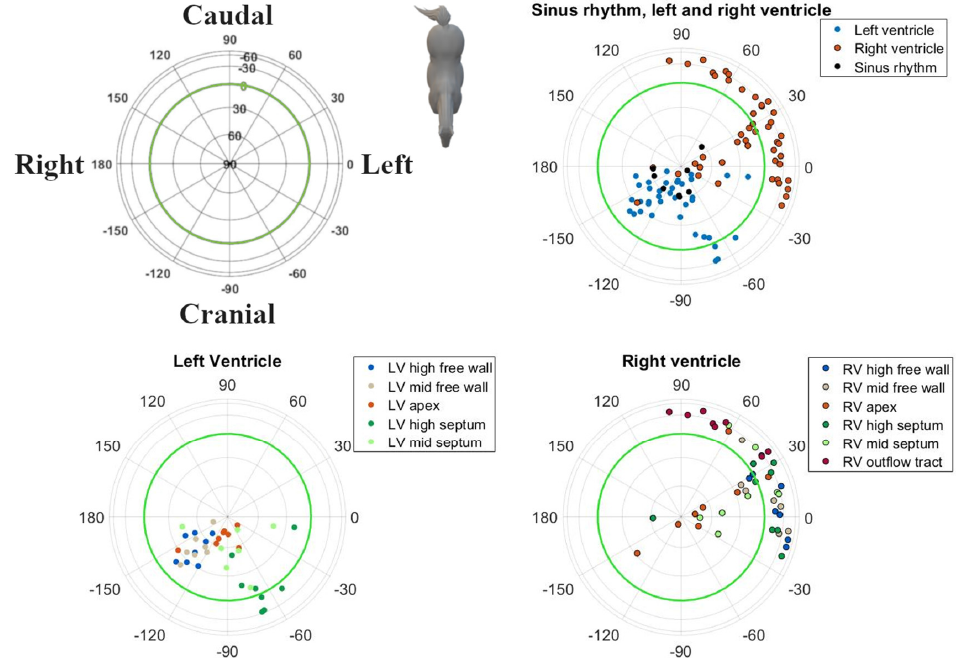
Figure 4. Spatial directions of the maximum electrical axis (MEA) of the QRS complex for individual induced VPDs and SR, visualized with a Lambert azimuthal equal-area plot. The spatial direction of the MEA was calculated over the entire QRS complex. Dots inside the green circle represent a dorsal MEA, while outside dots represent a ventral MEA. Left is 0 ◦ , caudal is 90 ◦ azimuth and dorsal is 90 ◦